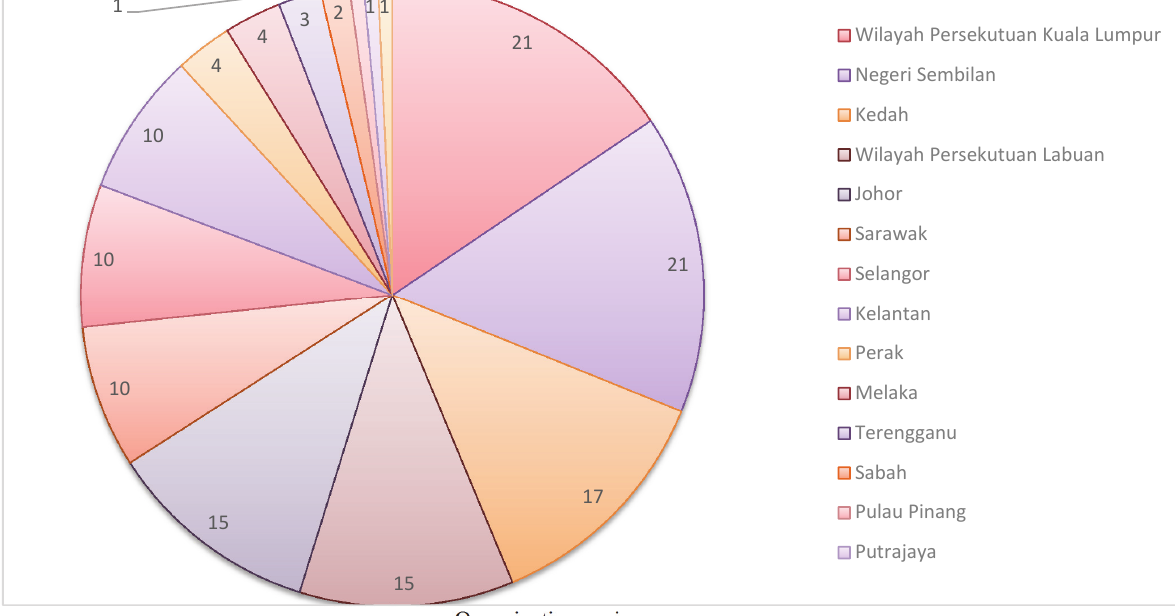
Fig. 6. Personal characteristics of the participants Cronbach’s alpha reliability test result Construct